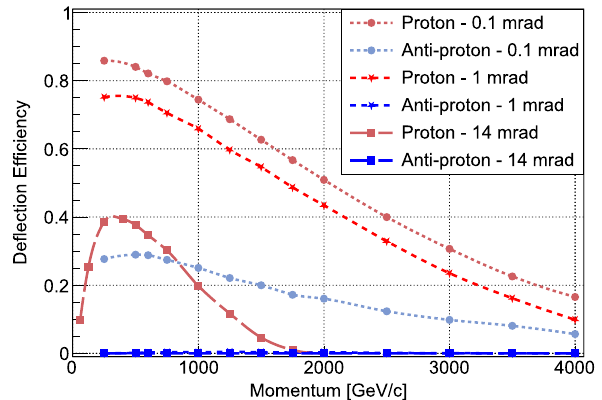
Fig. 1 Dependenceofthechannelingefficiencyofprotonsandantipro- tons with the particle momentum for 1 mm, 1cm and 7cm long Si crystals bent along the ( 110 ) plane by a 0 . 1mrad, 1mrad, and 14mrad bending angle, respectively. The curves for the anti-proton interacting with the 1cm and 7cm long Si crystals are